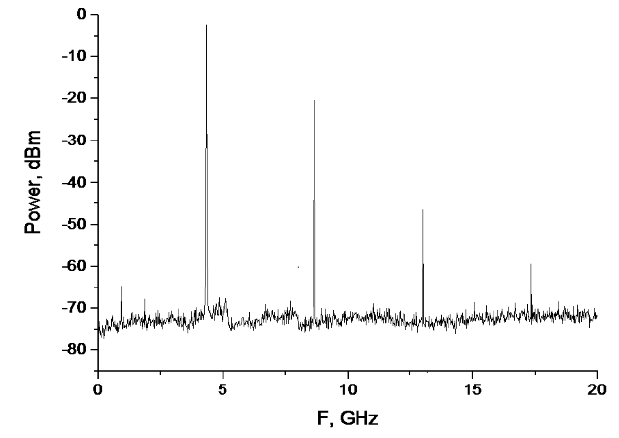
Figure 7. Higher harmonics in the generation spectrum that were observed with the narrowband demodulation without a YIG filter for approximately 4 GHz detuning of the laser frequency from the acetylene absorption line.